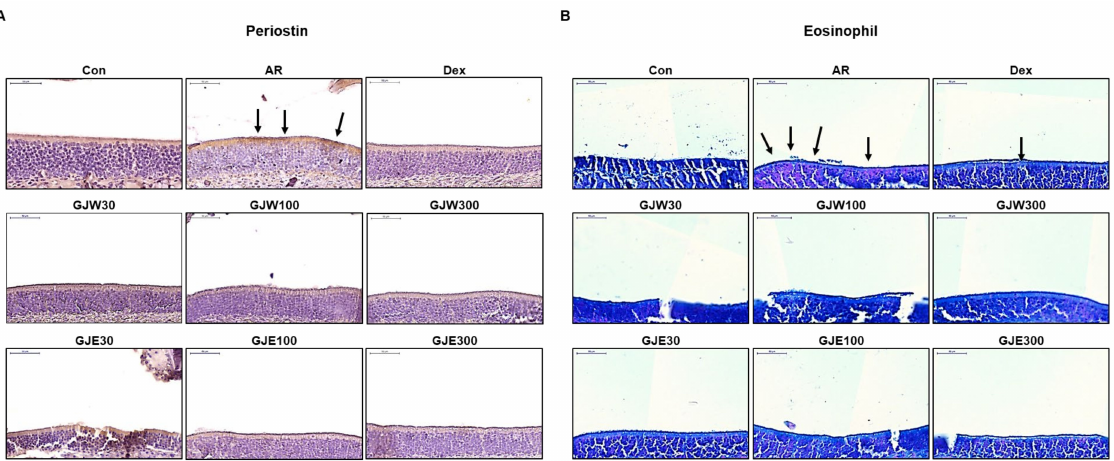
Figure 3. Effects of Gardenia jasminoides water (GJW) and 70% ethanol (GJE) extracts on histopathological changes in the nasal tissue. Immunohistochemical staining of periostin ( A ) and eosinophil staining ( B ) (upper left corner, scale bar = 50 µ m). Con, non-sensitized; AR, allergic rhinitis; DEX, ovalbumin-sensitized with 1 mg/kg